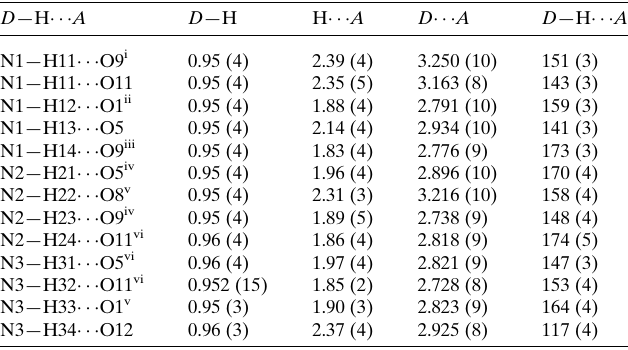
Table 1 Hydrogen-bond geometry (A˚ , (cid:3)